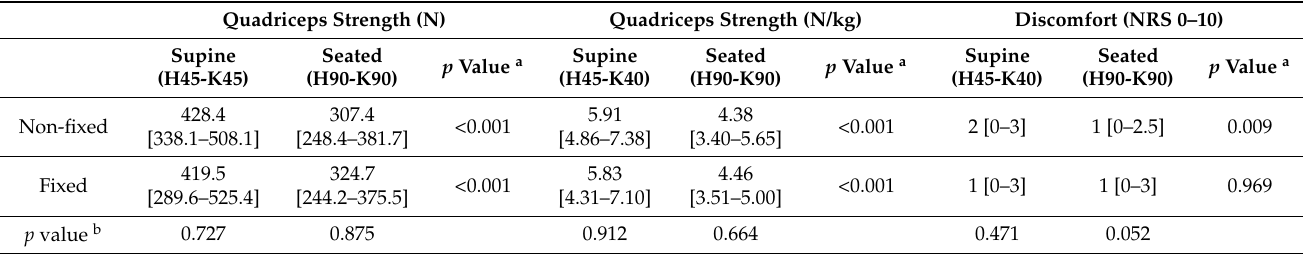
Table 1. Raw and relative quadriceps strength, and discomfort scores according to testing positions and dynamometer configurations. p value a : p value related to comparisons between the two positions. p value b : p value related to comparisons between the two dynamometer